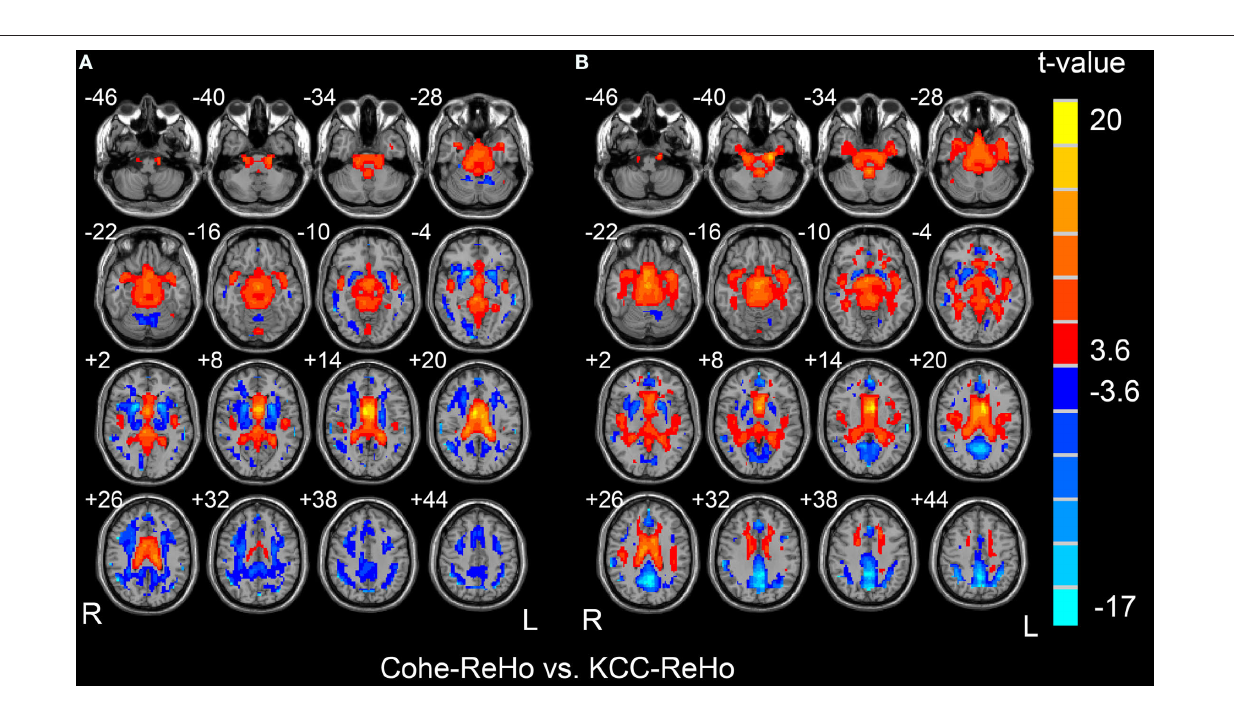
In the supersellar cisterns and ventricles, both linear correla- tion (See Section Correlation analysis) and paired t -test showed that Cohe-ReHo and KCC-ReHo were different from each other. All these results indicated that the physiological noise may